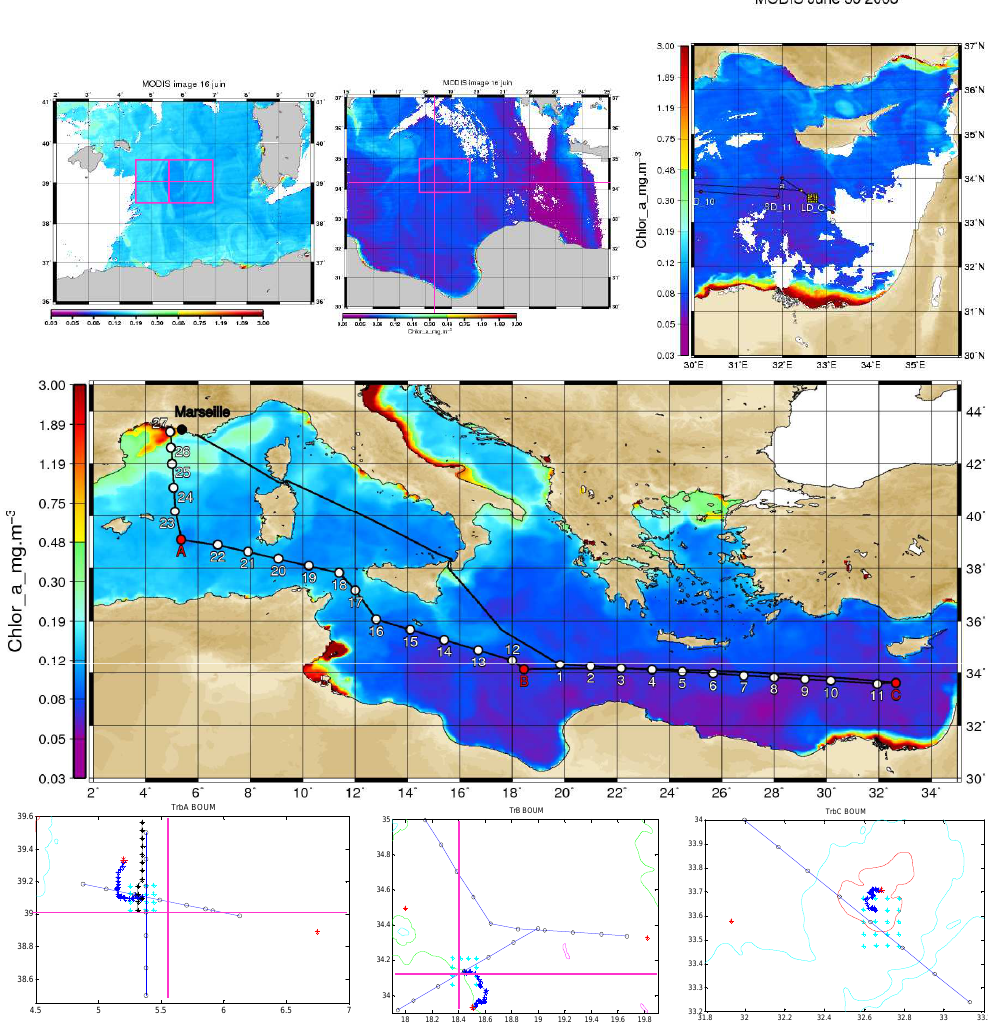
Fig. 2. Middle: transect of the BOUM cruise superimposed on a SeaWiFS composite image of Chl a concentration in the upper layer of the MS between 16 June and 20 July 2008. The two types of stations, short duration and long duration, are indicated. The three LD stations investigated for a period longer than four days are indicated in red and are located in the centre of an anticyclonic eddy (courtesy of E. Bosc). Top: small size colour images indicating the location of eddies prior to sampling. The rectangles in red correspond to the maps detailed below. Bottom: XBT survey (black circles) and sampling grid stations (cyan crosses) investigated to locate eddy centres. An additional south-to-north CTD cast section is shown for eddy A (in black). The locations of each 0–500dbars cast for the LD stations are shown in blue indicating estimates of the drifting of the eddy centres during 3 days. The red crosses indicate the locations of the deep casts performed at the end of LD station occupation. The 1000, 2000 and 3000m bottom depths isolines are indicated in red, cyan and green, respectively. All figures could be increased in size on the screen to get all the